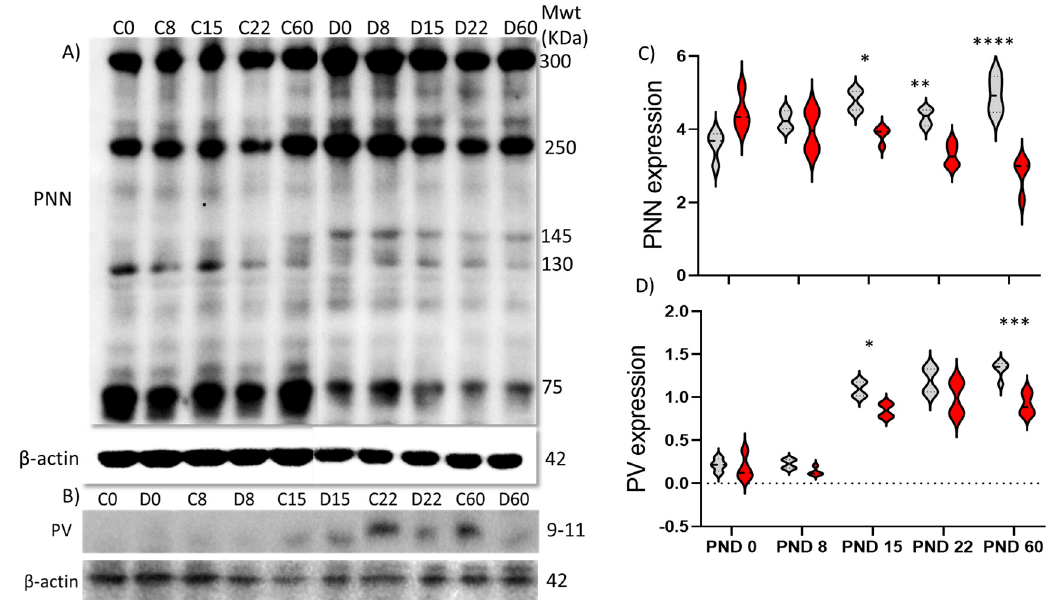
Figure 2. Age-wise expression of perineuronal net components. ( A ) perineuronal net components from PFC lysates (notations above the blots: C refers to control and D refer to 129S: ∆ DISC1 at the respective postnatal ages in days); ( B ) parvalbumin band. Beta-actin expression was used as a loading control; ( C , D ) quantitative expression of PNN and PV, respectively. Black and red lines indicate of Control and DISC1 mutation animals, respectively. The data are represented as a scatter line plot showing mean ± s.e.m. where * p ≤ 0.05, ** p ≤ 0.01, *** p ≤ 0.001, and **** p ≤ 0.0001 by two way-ANOVA.